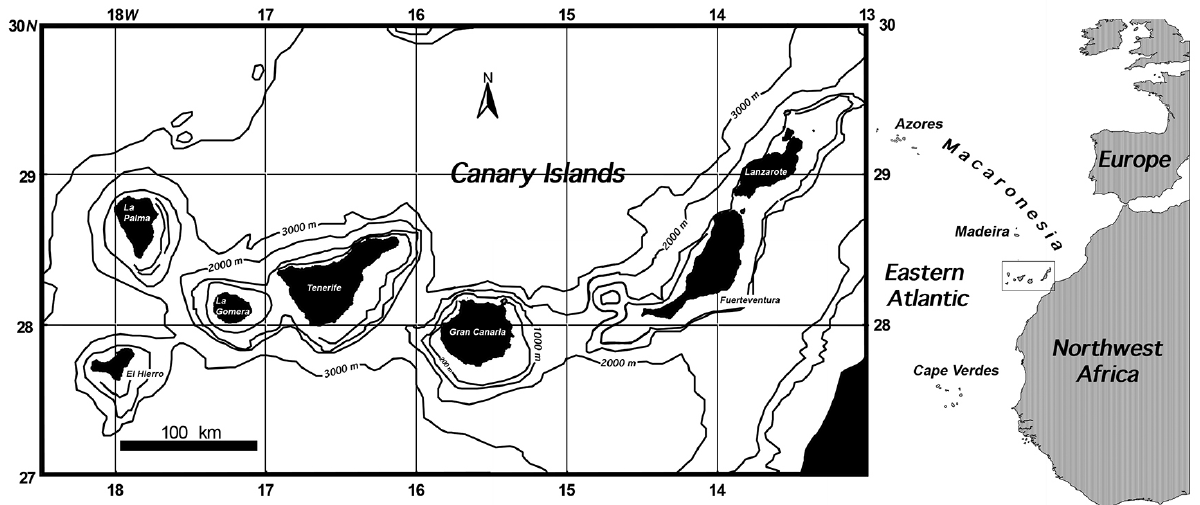
Fig. 1. – Map of the Canary Islands (northeastern Atlantic) showing their geographic situation and bathymetric